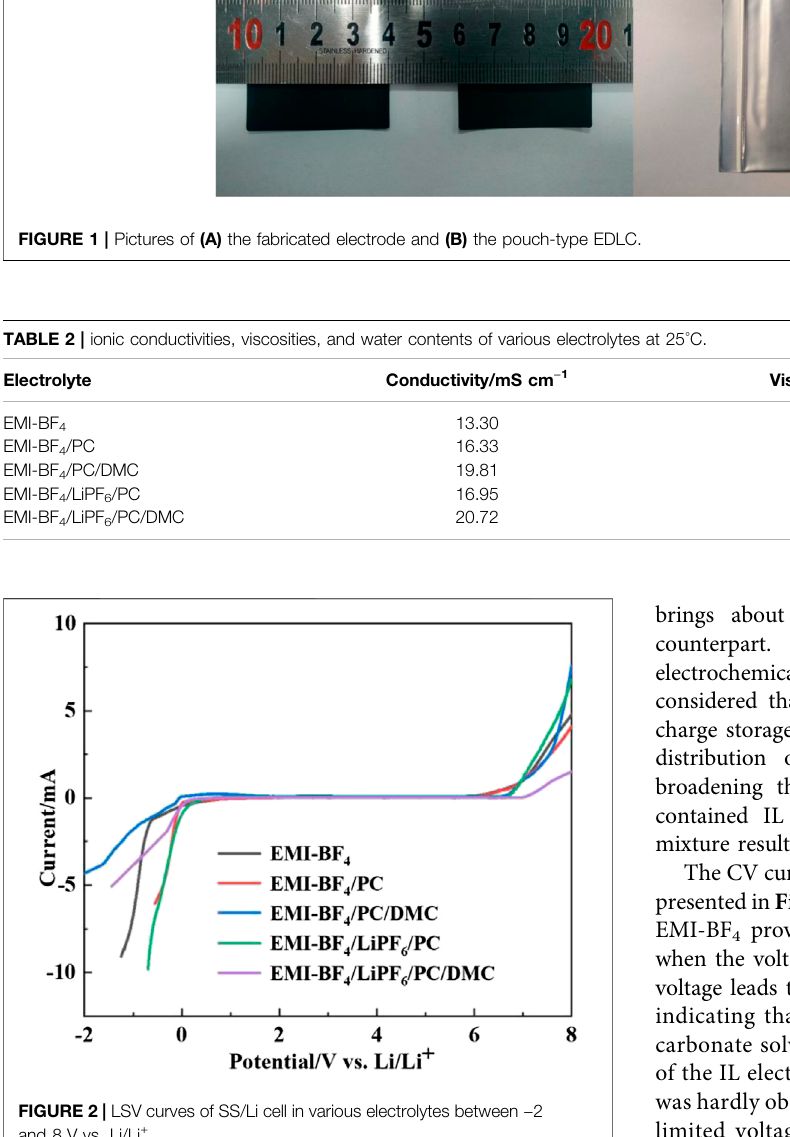
Frontiers in Materials |